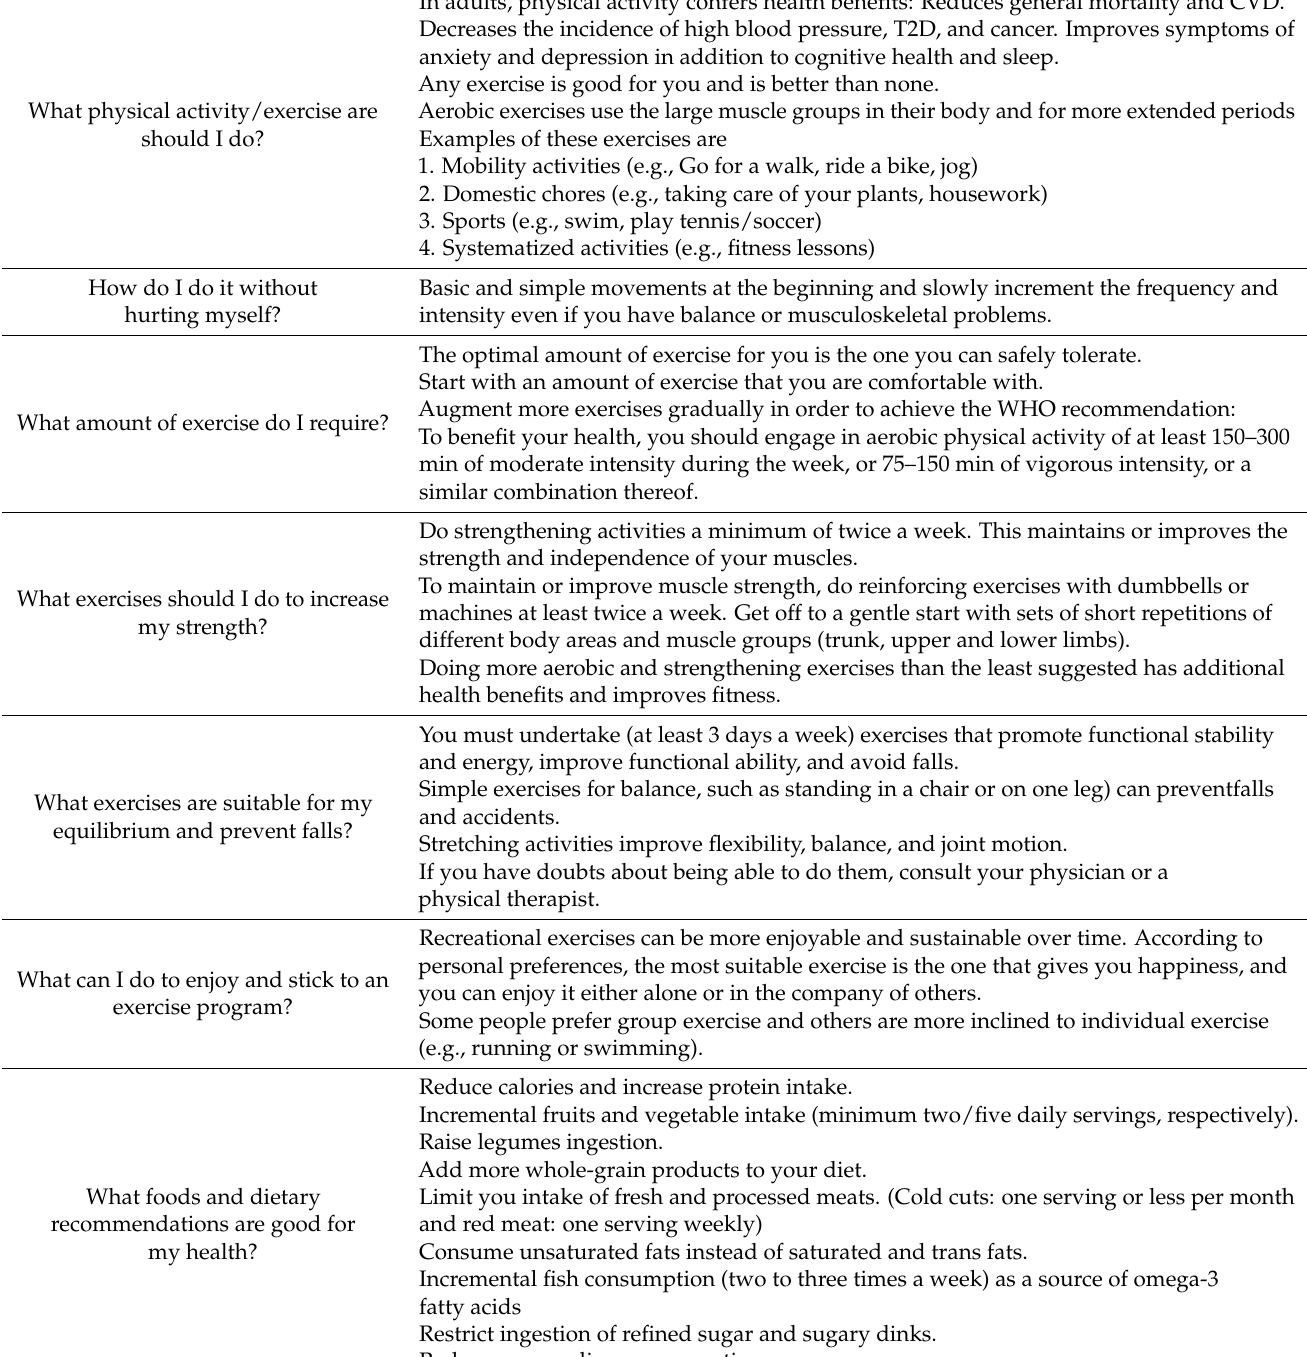
Table 2. Recommendations on physical activity and Mediterranean Diet for successful aging: A clinician-patient Guide. Usual Patient Questions Practical